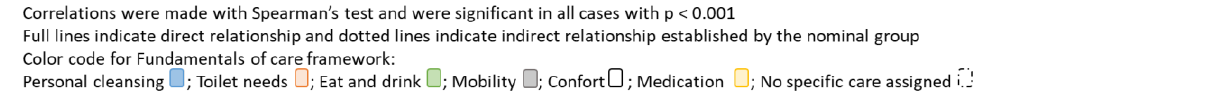
Figure 1. Direct and indirect relationships and Spearman’s correlation test analysis between items